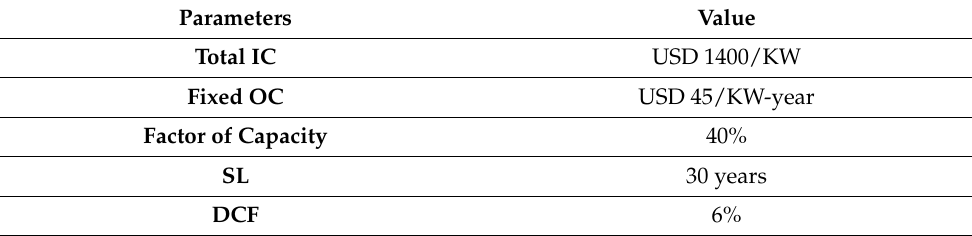
Table 3. Test case